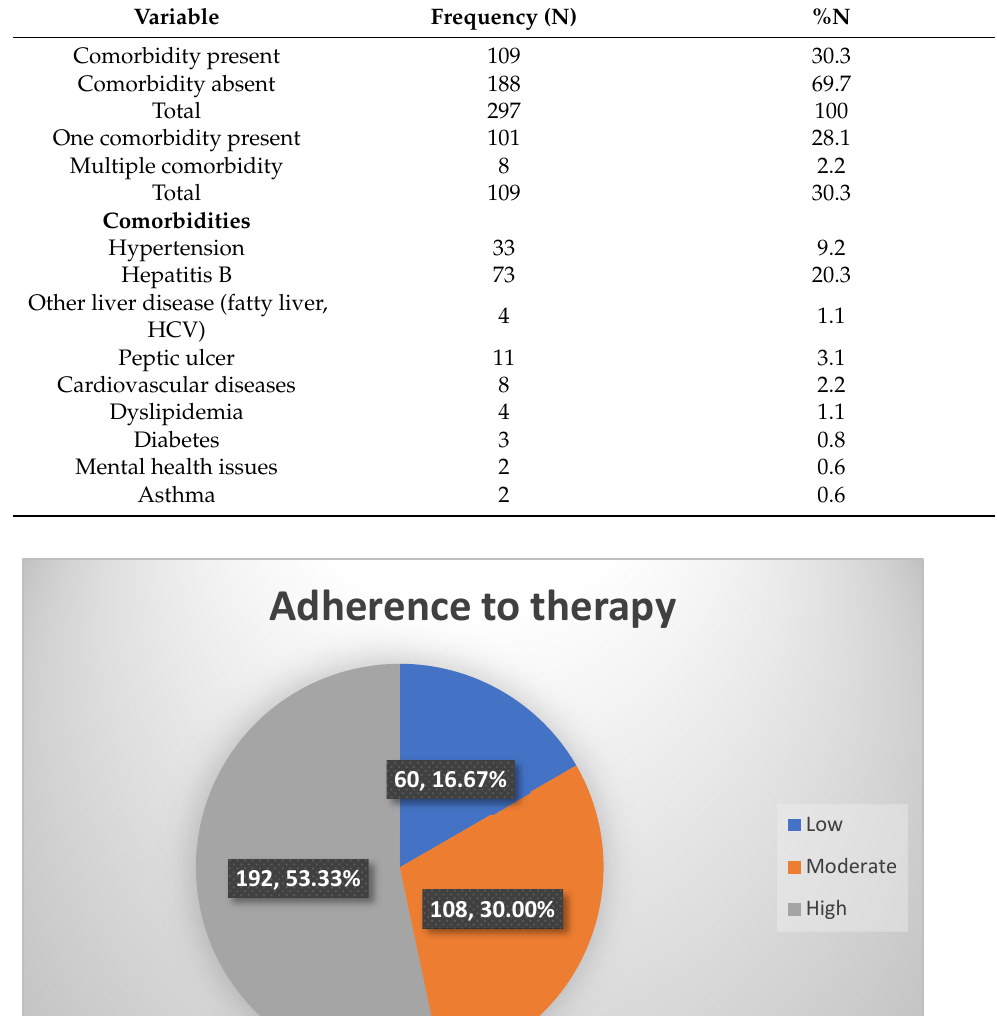
Table 2. Prevalence of Comorbidities.